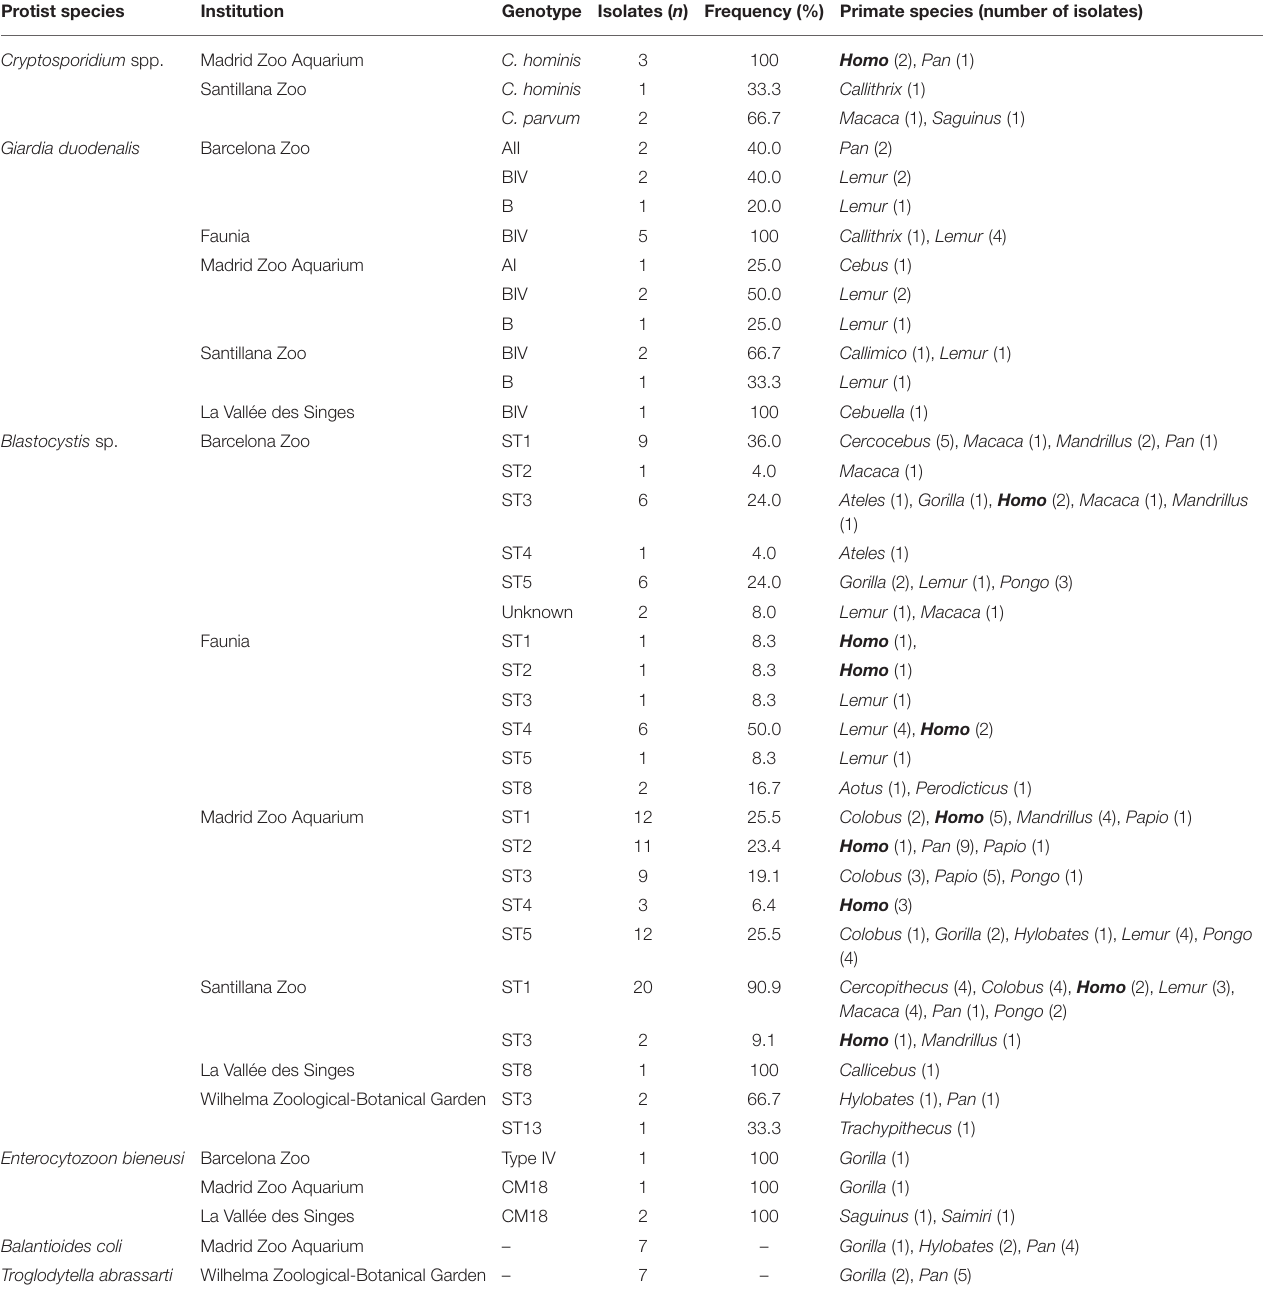
Members of the genus Homo are shown in bold to identify scenarios where zoonotic transmission events may